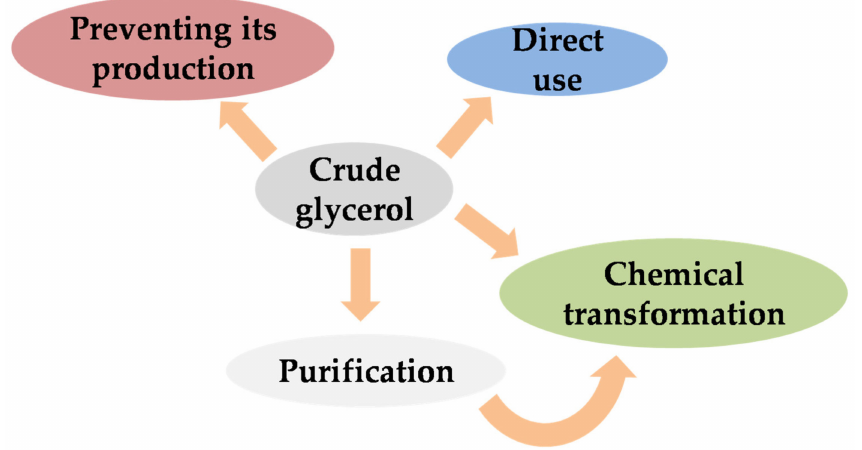
Figure 3. Main options for crude glycerol management.